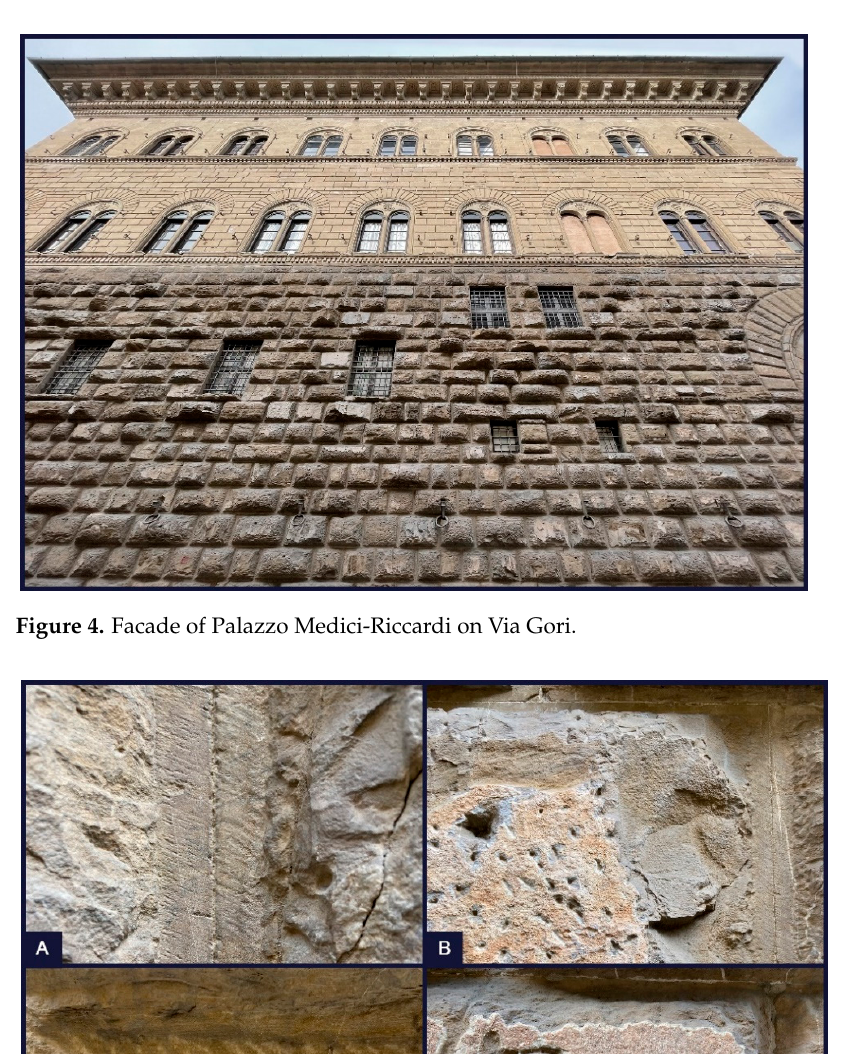
Figure 4. Facade of Palazzo Medici-Riccardi on Via Gori.